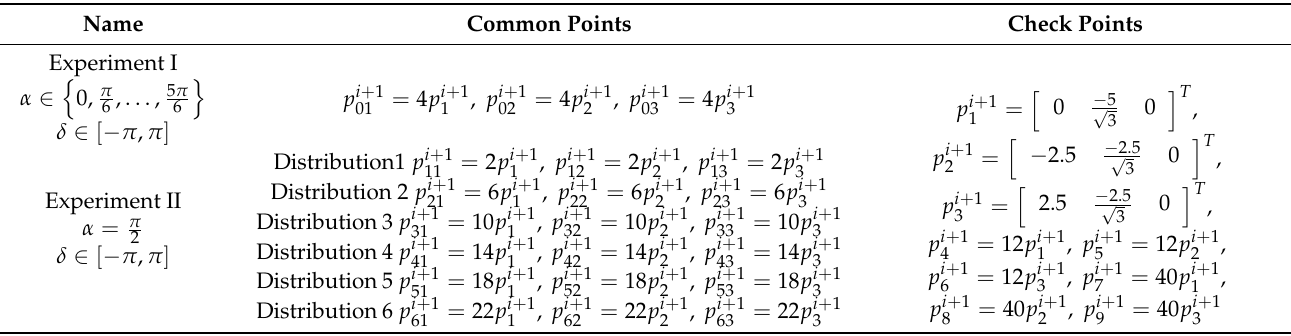
Table 1. The true coordinates of common points and check points